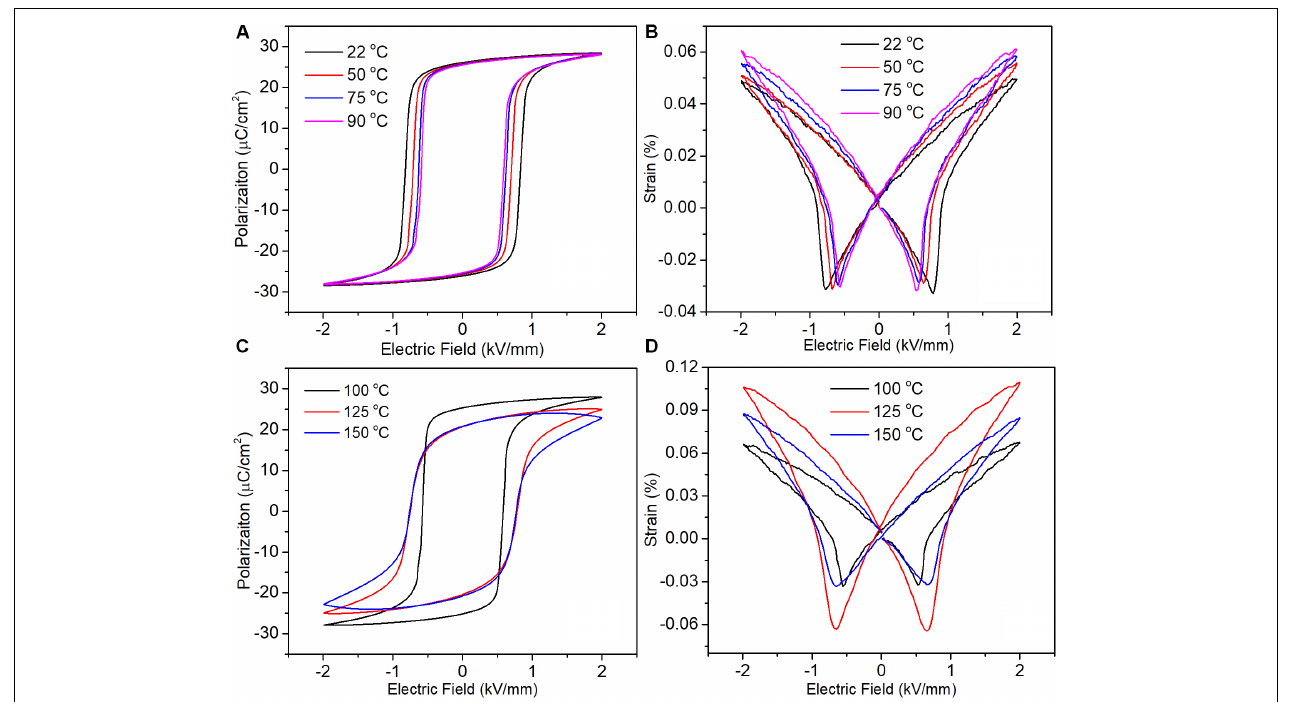
FIGURE 10 | For composition at x = 1 mol.% (A) P–E loops at selected temperatures from 22–90 ◦ C; (B) S – E loops at selected temperatures from 22–90 ◦ C; (C) P–E loops at selected temperatures from 100–150 ◦ C; and (D) S–E loops at selected temperatures from 100–150 ◦ C.